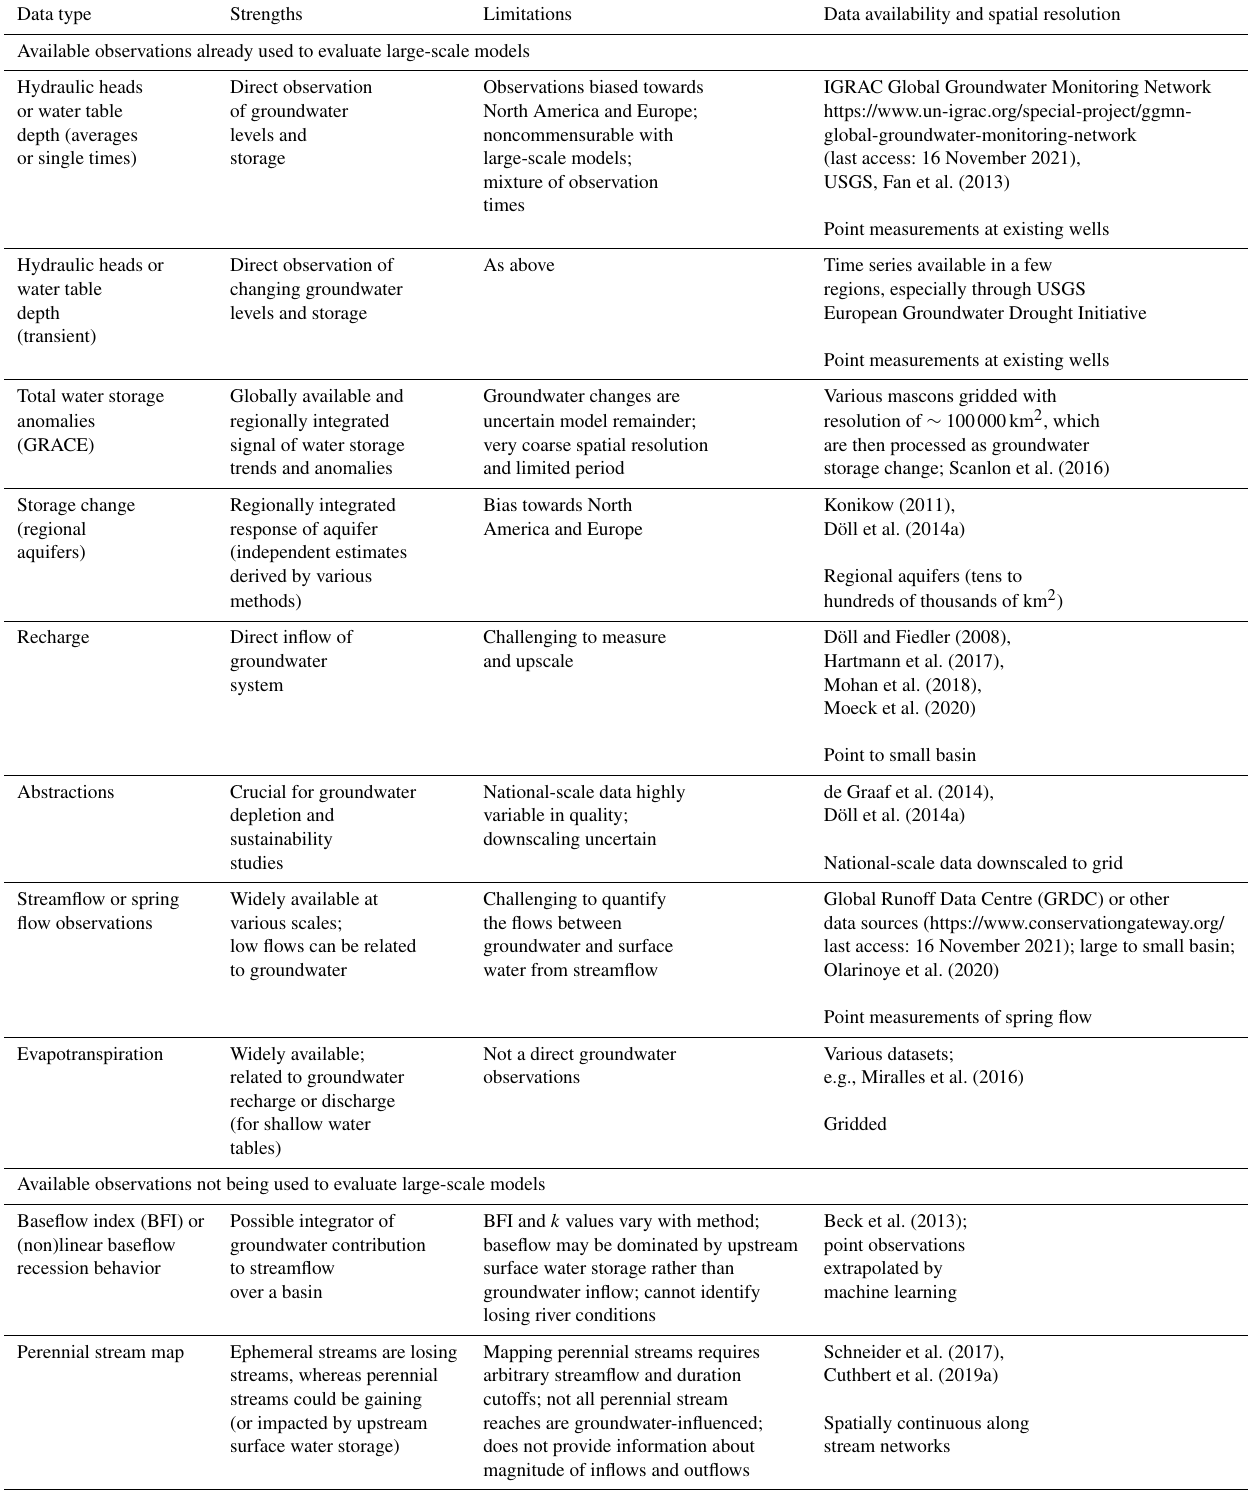
Table 2. Available observations for evaluating the groundwater component of large-scale